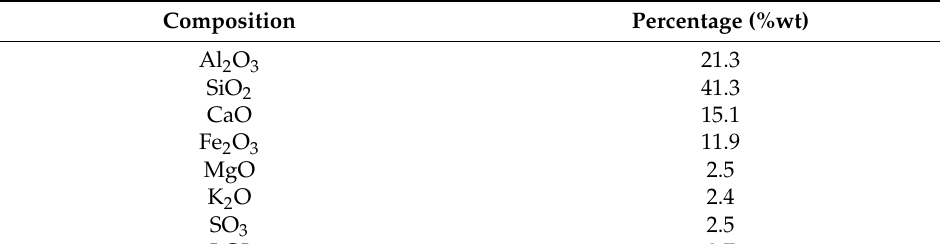
Table 1. Chemical composition of fly ash.